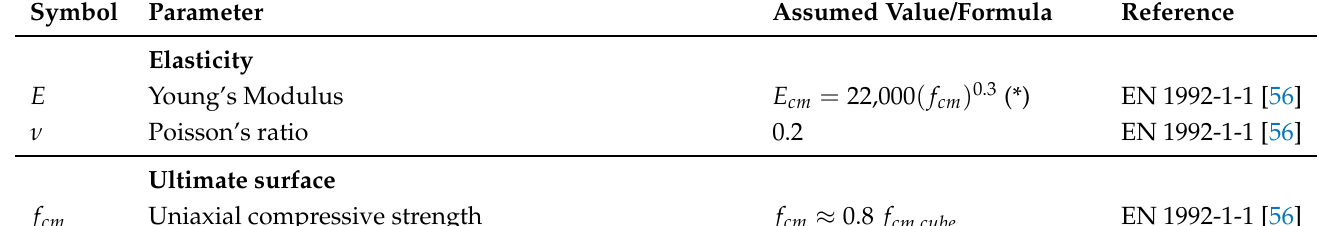
Table 8. The calibration of the CDP model—main assumptions. (*)—strength substituted in MPa and dimensions in mm. Symbol Parameter Assumed Value/Formula Reference